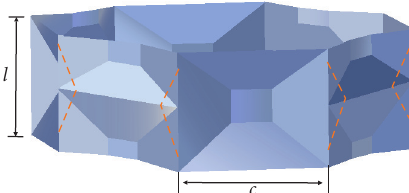
Figure 11: Illustration of a single module of the prefolded pat- terned tube with an octagonal profile.